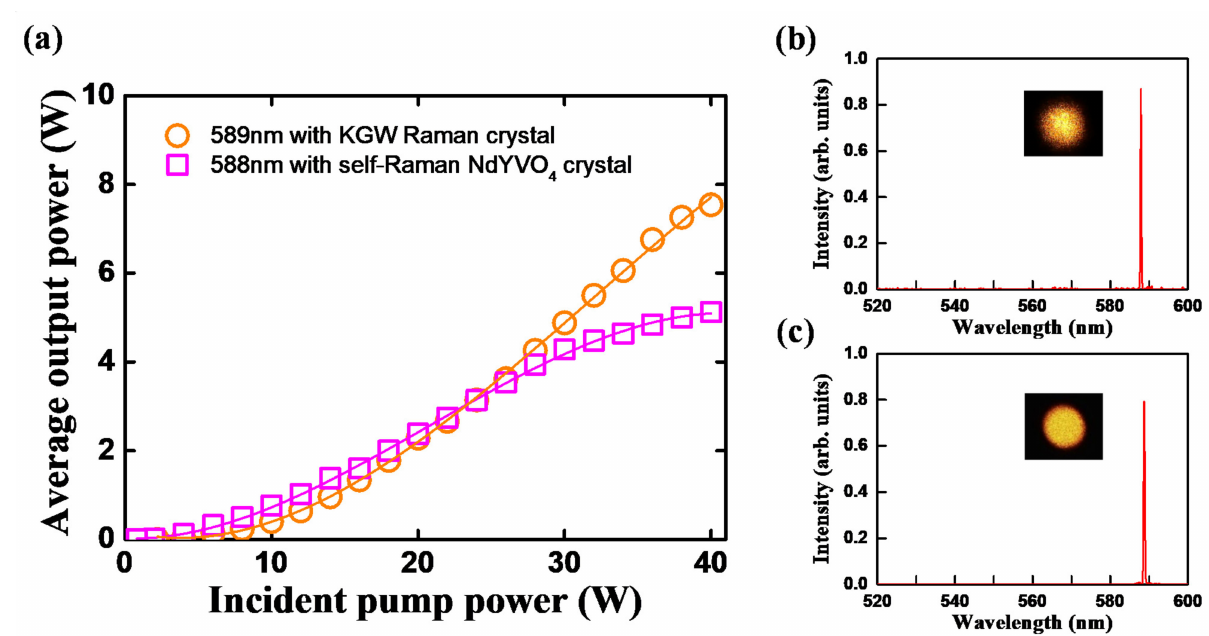
Figure 4. ( a ) The output power at 588 nm and 589 nm versus the incident pump power. Optical spectra of 588 nm and 589 nm wavelengths and corresponding transverse mode patterns in the ( b ) self-Raman Nd:YVO 4 laser and ( c ) Nd:YVO 4 /KGW Raman